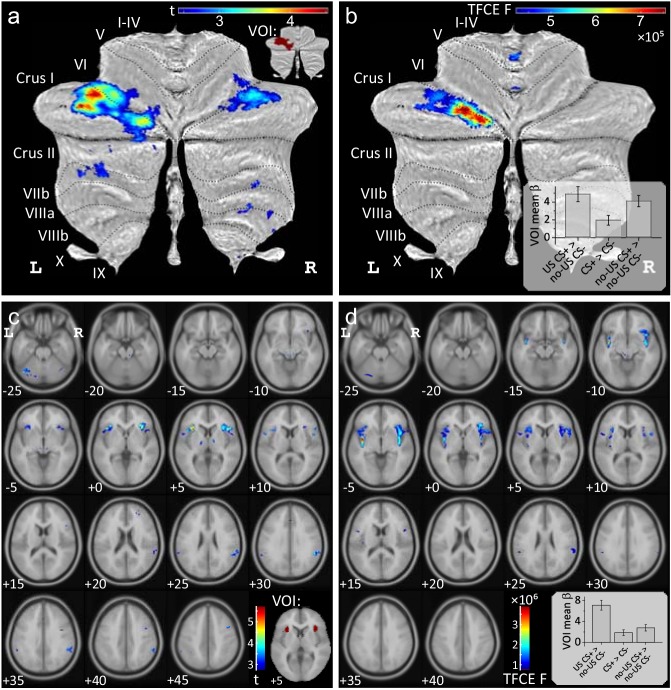
Conjunction analyses.Conjunction analyses testing global null hypotheses (a,c) and analyses of differences (b,d) between the three contrasts ‘US post CS+ > no US post CS-', ‘CS+ > CS-’ and ‘no-US post CS+ > no US post CS-’ (shown in Figure 3) during fear acquisition. Data in (a,b) is shown in SUIT space and in (c,d) in MNI space. All contrasts displayed using FWE correction (p<0.05), (b,d) using TFCE. Bar graphs display group mean β values for each contrast considering the whole activation volume (error bars: standard error). VOI were defined based on conjunction analyses and are shown in the inserts: cerebellar VOI (a) and bilateral insula VOI (c). CS = conditioned stimulus; FWE = familywise error; TCFE = threshold-free cluster-enhancement; US = unconditioned stimulus; VOI = volumes of interest.10.7554/eLife.46831.012Figure 4—source data 1.Mean β data.